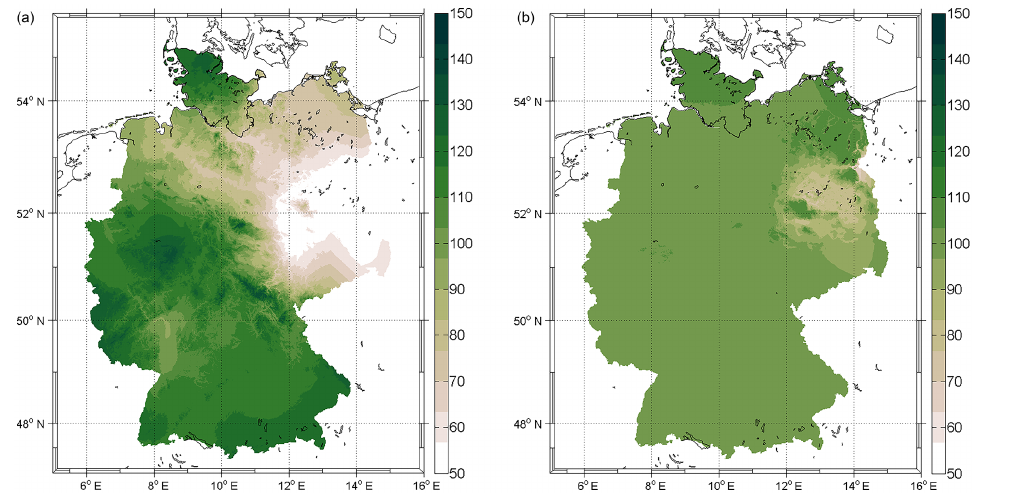
Figure 6. (a) Soil moisture in % nFK for sandy loam soil and (b) for loamy sand soil, 21 December 2014 (Model calculations by ZAMF, Braunschweig, Germany). The boundaries of Schleswig-Holstein are marked in